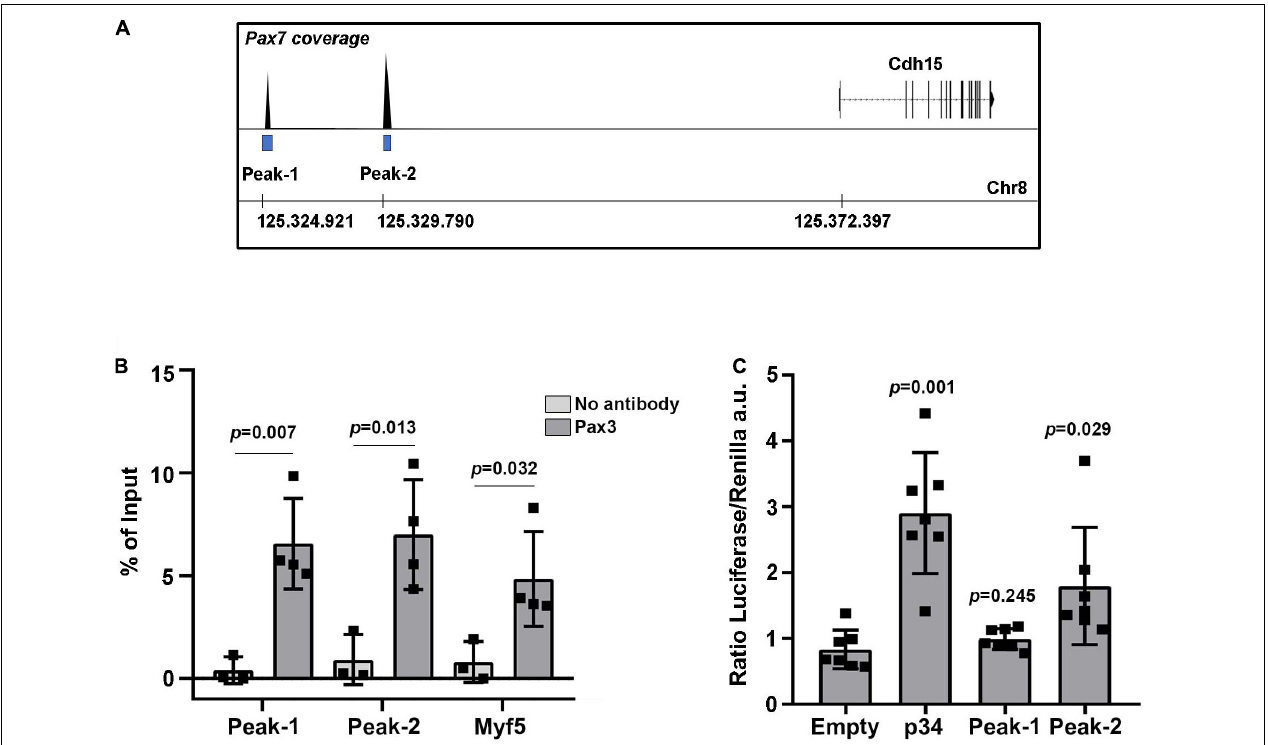
FIGURE 5 | Identification of M-Cadherin as a direct target of PAX3. (A) Schematic representation of the detected peaks bound by PAX7 from Soleimani et al. (2012) upstream of the M-Cadherin gene ( Cdh15 ) locus. (B) ChIP-RT-qPCR for PAX3 on Peak-1 and Peak-2 and on the positive control at − 57 kb upstream of Myf5 . Graph represents the mean with standard deviations. The p -value was calculated with a two-tailed paired t -test. (C) Quantification in arbitrary units of the ratio between luciferase and renilla (transfection control) in the presence of an expression vector for PAX3 and a plasmid containing the luciferase gene under the control of the p34 sequence, as a positive control, the Peak-1 sequence, the Peak-2 sequence or no potential PAX3 binding sequence (empty). Graph represents the mean with standard deviations. The p -value was calculated with a two-tailed paired t